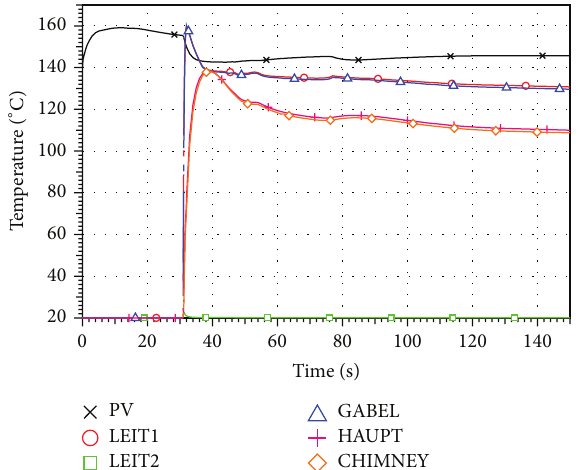
Figure 10: Base case scenario: gas temperature in the nodes. spike is observed. The highest pressure peak is observed in LEIT1; that is, piping part connected to PV and peaks are smaller going further from PV.